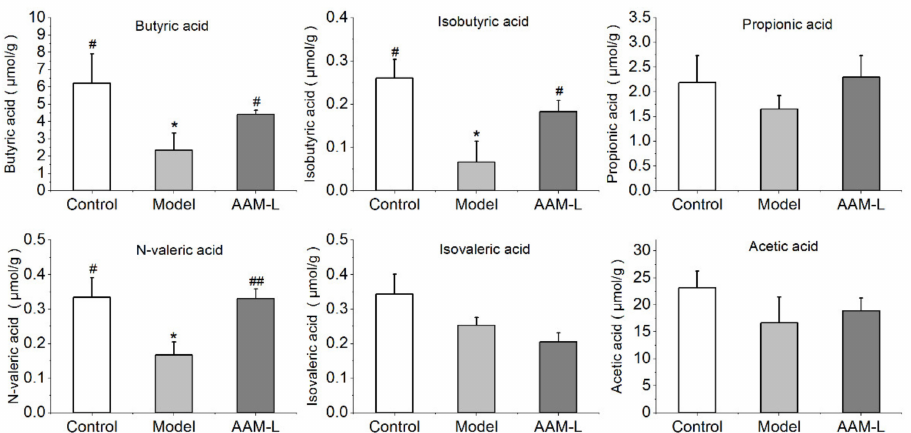
Figure 6. Effects of AAM administration on the content of intestinal short-chain fatty acids (including acetic acid, propionic acid, butyric acid, isobutyric acid, n-valeric acid and isovaleric acid) in mice exposed to alcohol intake for consecutive 6 weeks. ## p < 0.01 and # p < 0.05, versus the Model group; * p < 0.05, versus the Control